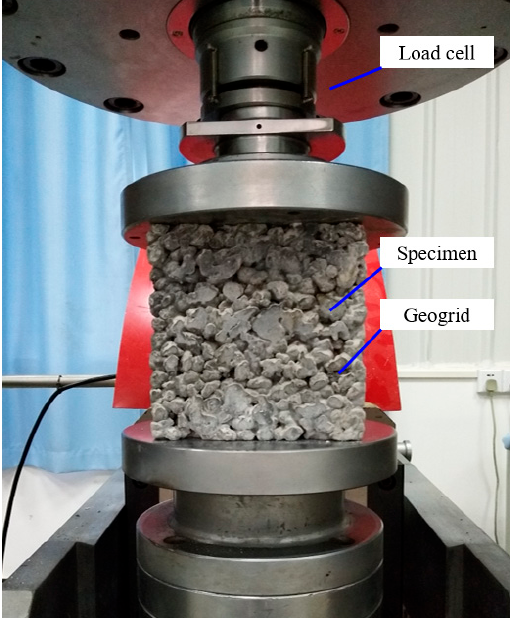
Figure 5. The unconfined compressive strength test setup.